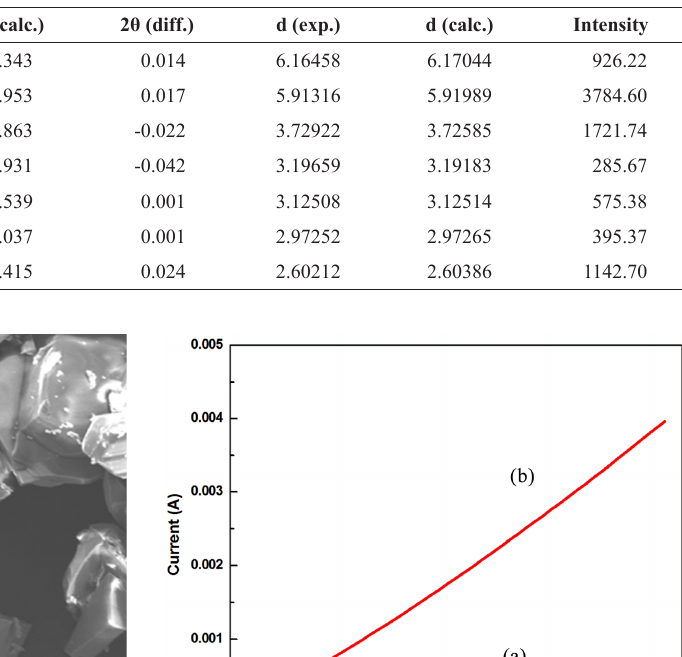
Table 2. Evaluated parameters from the XRD data of PANI composite.